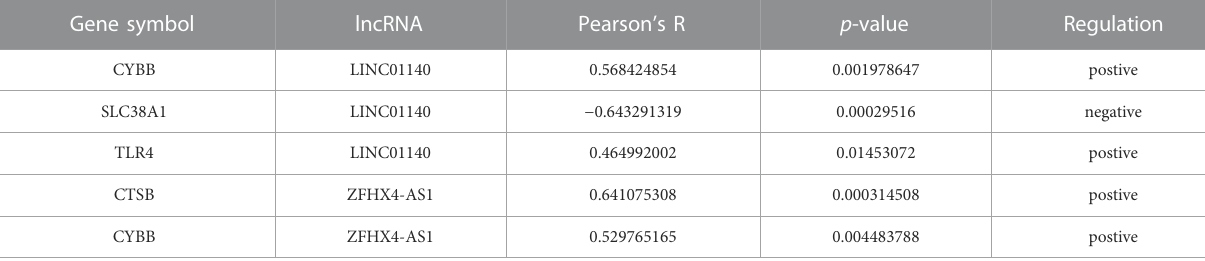
TABLE 3 Correlation of Differentially Expressed FRGs and two